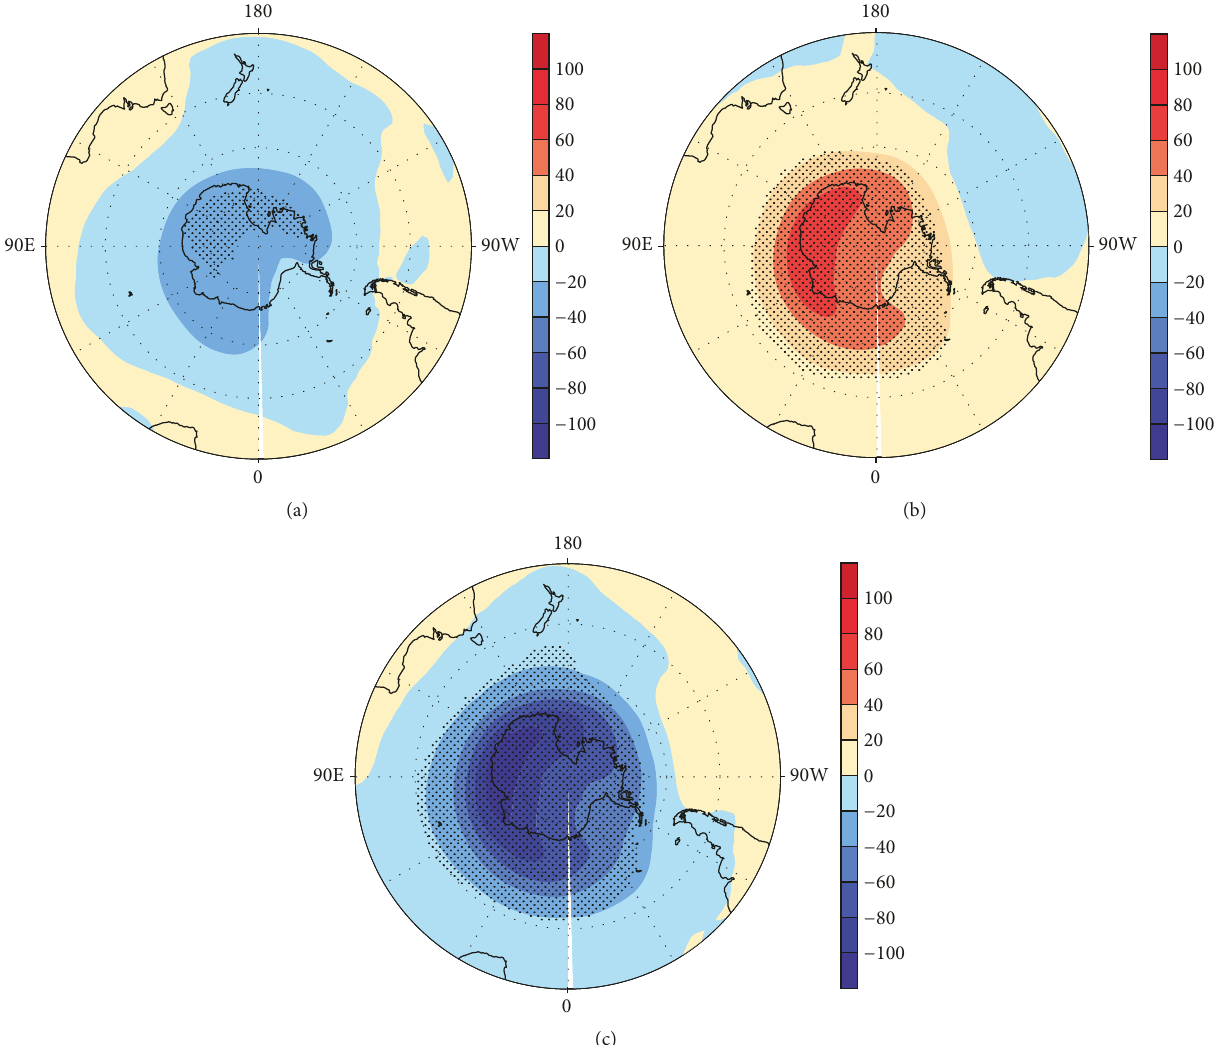
Figure 7: Composite anomalies of September-October total column ozone (units: DU) in (a) high-value PVBTI years and (b) low-value PVBTI years. (c) Composite difference of total column ozone (units: DU) between high-value and low-value PVBTI years. Dotted areas show significant changes at 95% level, estimated by local Student’s 𝑡